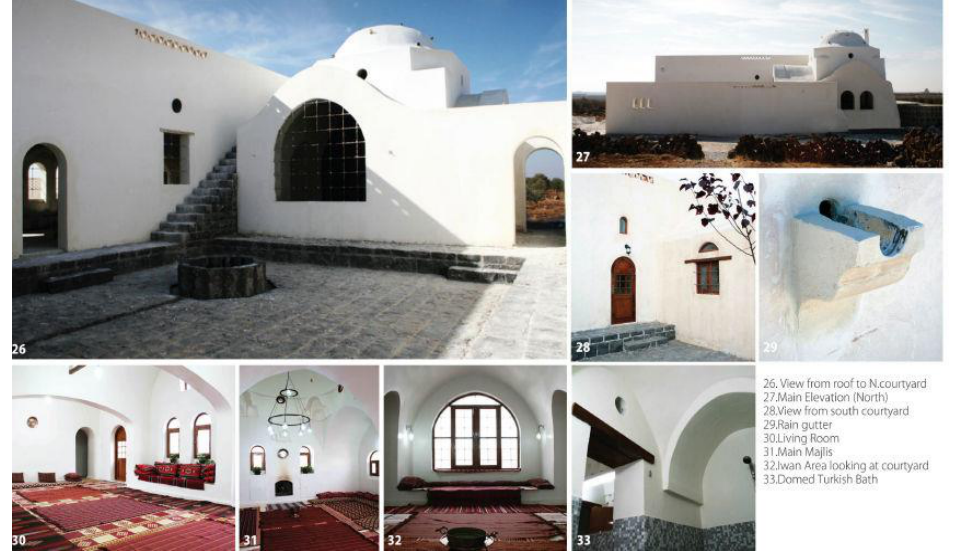
Figure 6. House finished (images courtesy of M. Hosam Jiroudy, Architect).